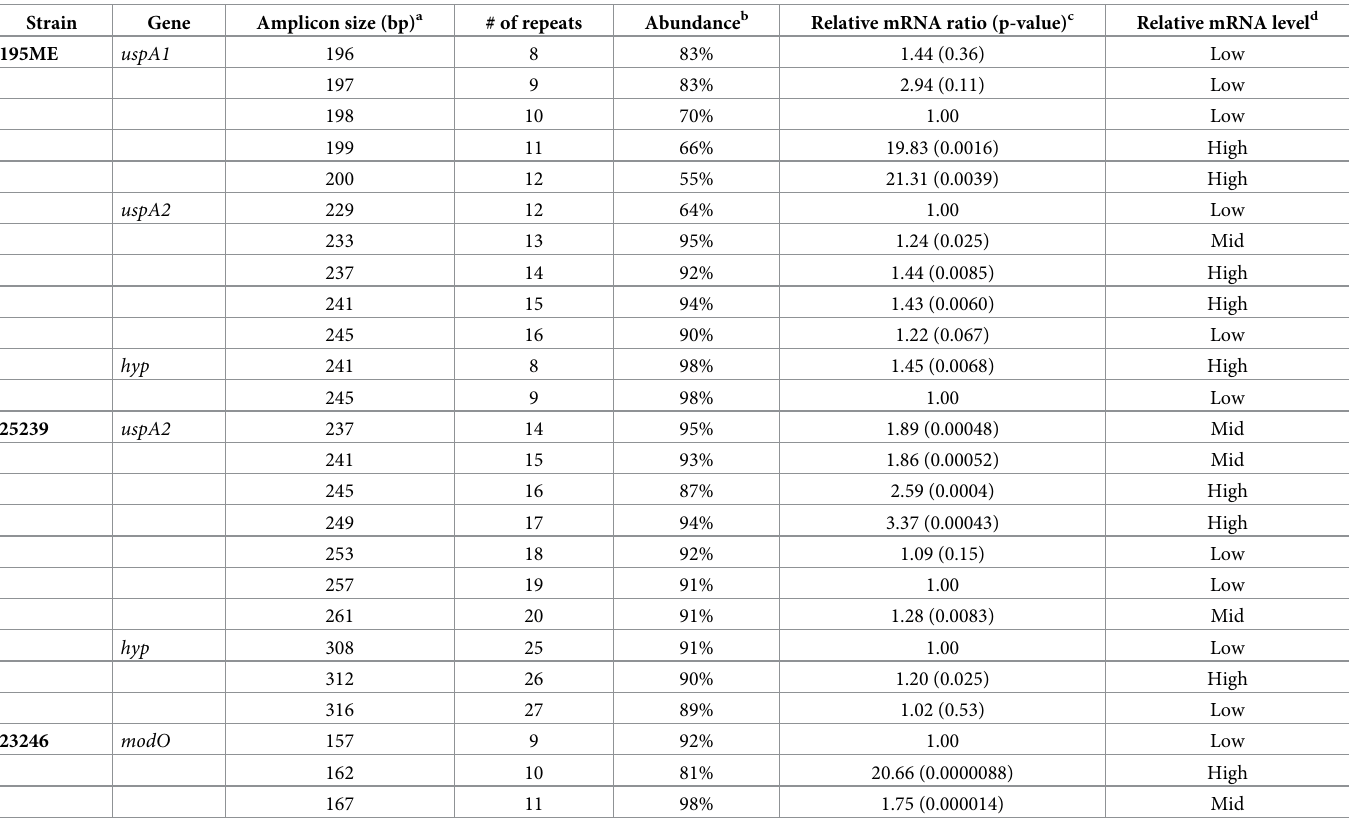
Table 2. Summary of fragment length analysis amplicon size, DNA repeat number and relative expression of phase variable gene panel populations used in this study.